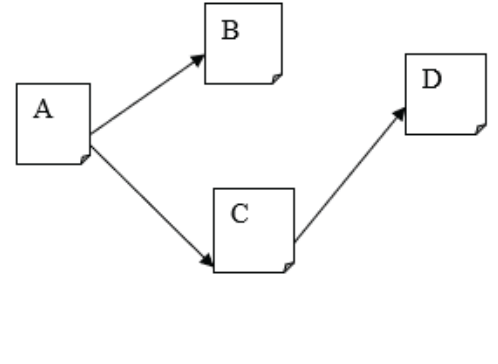
Figure 2: Example showing backlink of page